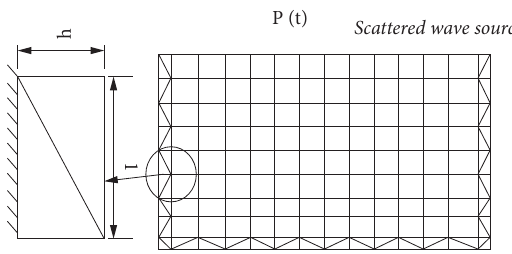
Figure 1: Equivalent viscous-spring artificial